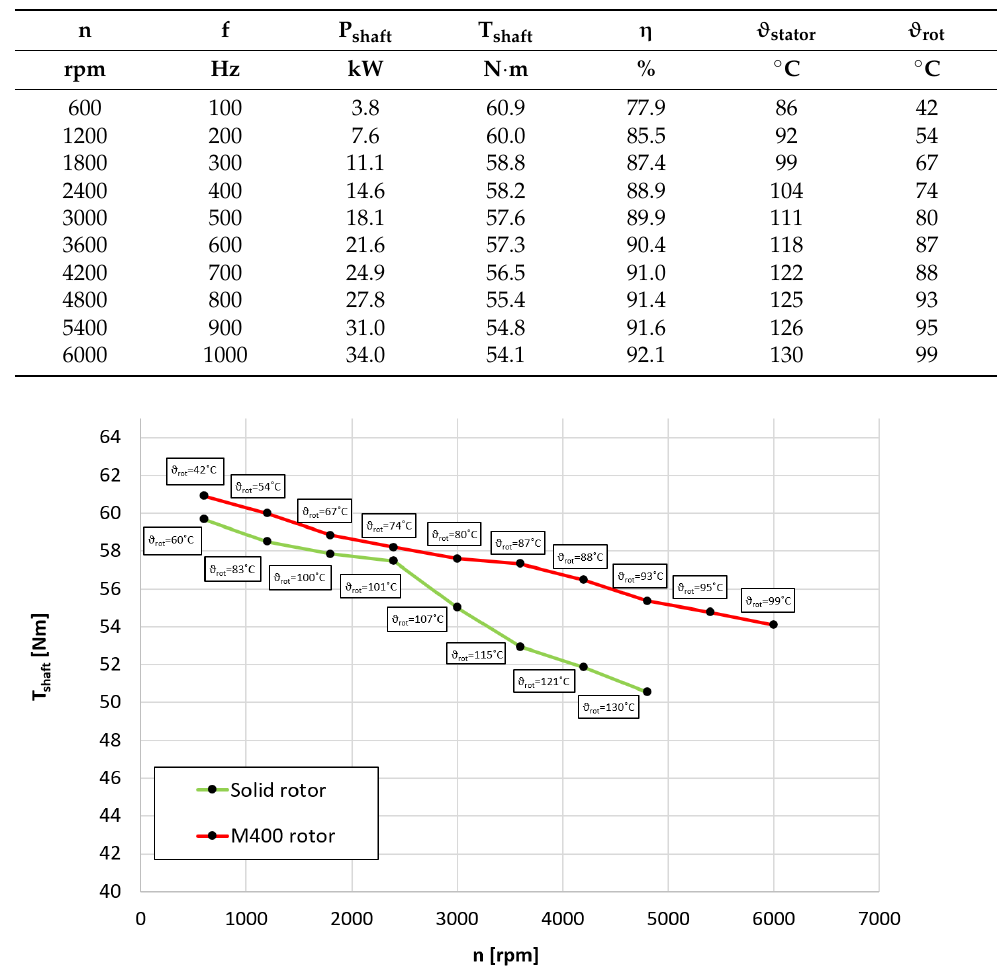
Figure 10. Comparison of the shaft torque as a function of changes in rotational speed for the rated load current I N .